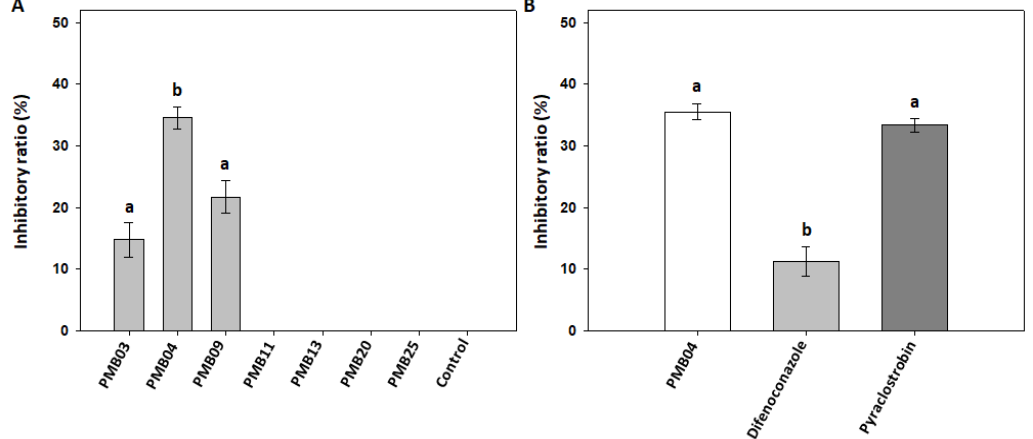
Figure 1. Inhibitory effects of Bacillus amyloliquefaciens strains and fungicides against mycelial growth of Colletotrichum gloeosporioides e. ( A ) shows the mycelial growth inhibition rate caused by the B. amyloliquefaciens strains on PDA-NA plates. The inhibition rates were calculated as described in the materials and methods. Sterilized water was used as a negative control. ( B ) reveals the inhibitory rate against mycelial growth caused by B. amyloliquefaciens PMB04, difenoconazole, and pyraclostrobin. In the assay, 20 μ L of difenoconazole and pyraclostrobin at 16.6 mg ai mL − 1 and 7.8 mg ai mL − 1 , respectively, were applied to the paper disc. Data represent mean ± SD. The different letters above the columns indicate significant differences based on Tukey’s HSD test (The F value for panels A and B were 16.7 and 64.5, respectively; p < 0.05).